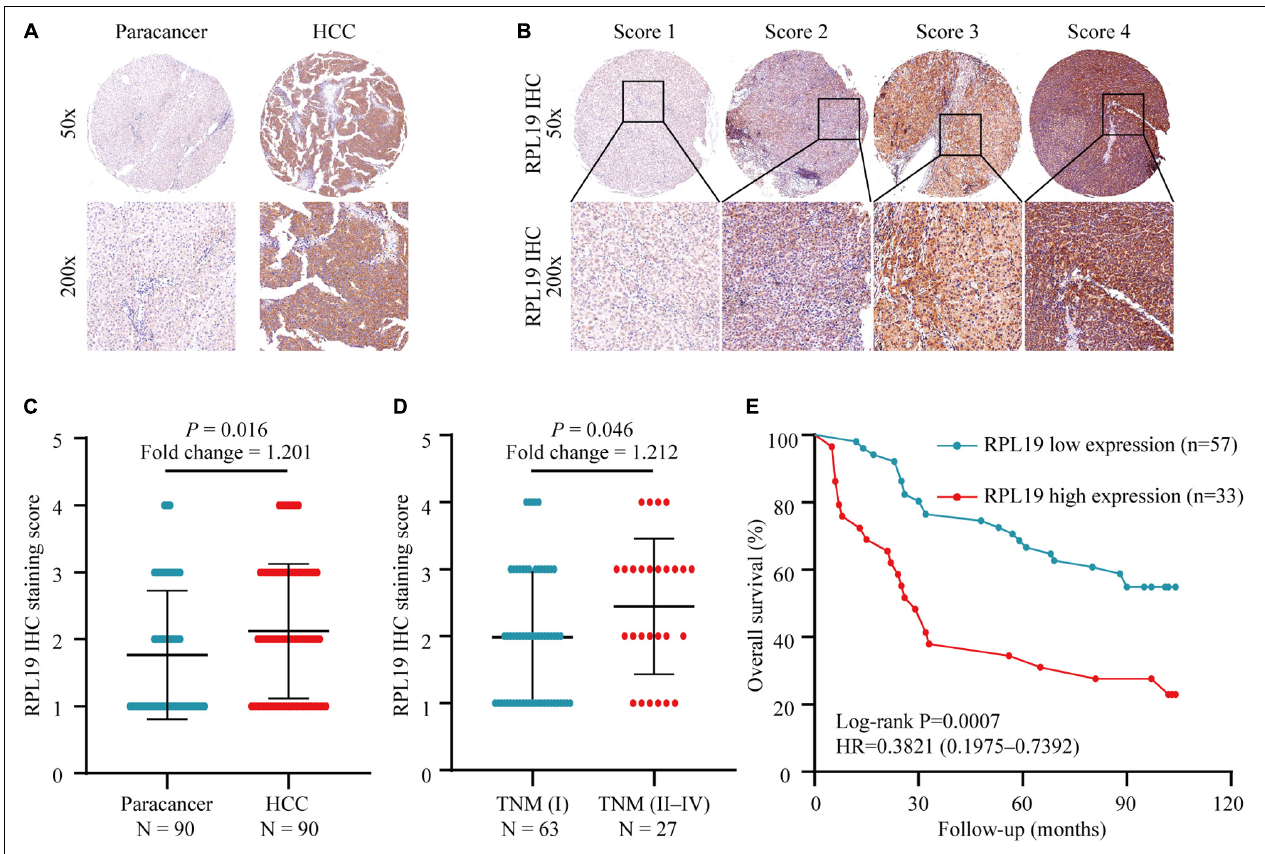
FIGURE 5 | Relationship between the expression of RPL19 in hepatocellular carcinoma and clinical prognosis. (A) RPL19 expression was higher in HCC patient tumor tissues than in paired paracancerous tissues. (B) IHC analysis of RPL19 expression in the TMA. (C) Expression of the RPL19 protein in the TMA in HCC and paracancerous tissues. (D) Expression of the RPL19 protein in the TMA in different TNM stages. (E) Relationship between the expression of the RPL19 protein and patient OS in the TMA. Differences between two groups were analyzed by Student’s t -test. The OS of HCC patients were calculated with Kaplan–Meier curves. TMA, tissue microarray; IHC, immunohistochemistry; HCC, hepatocellular carcinoma; OS, overall